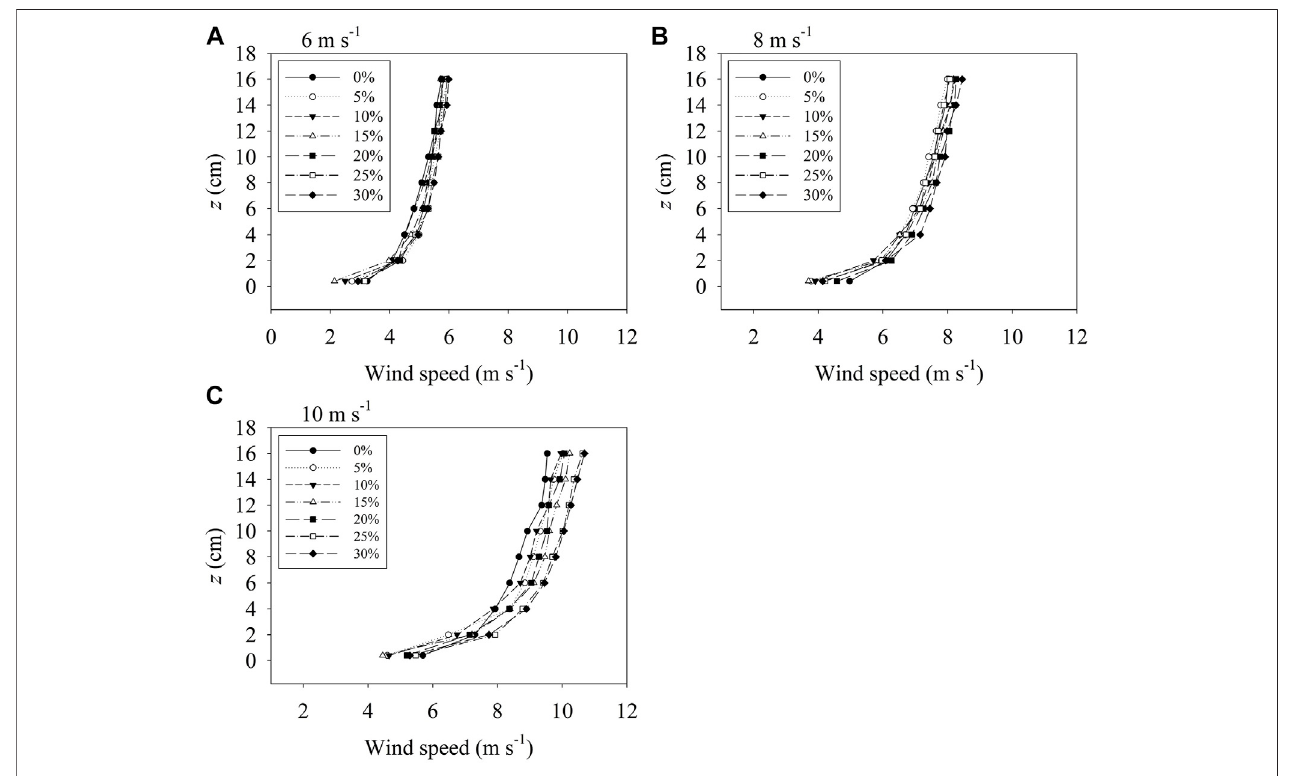
FIGURE 7 | Vertical wind pro fi les at different gravel coverages under wind speeds of (A) 6, (B) 8, and (C) 10 m s − 1 .